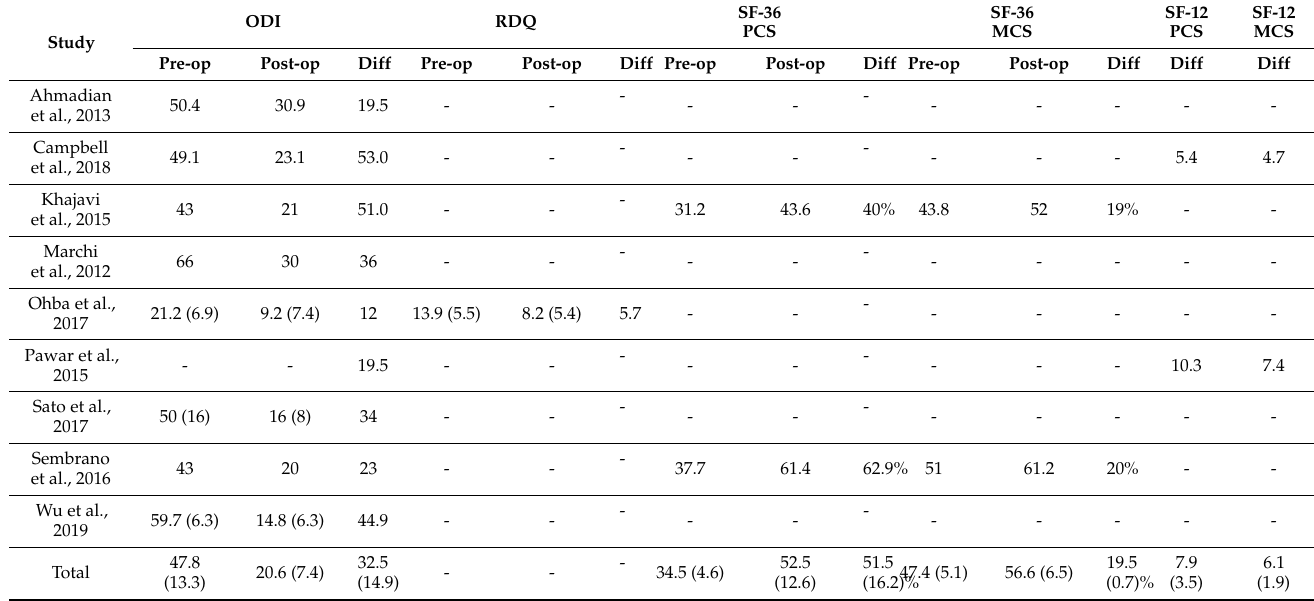
Table 4. Patient-reported outcomes measures (function and QOL) by the included studies.